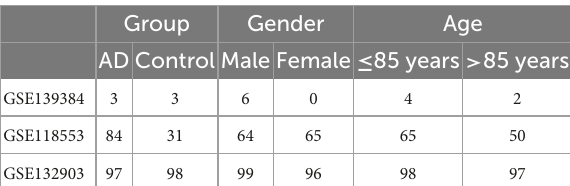
TABLE 2 Datasets clinical